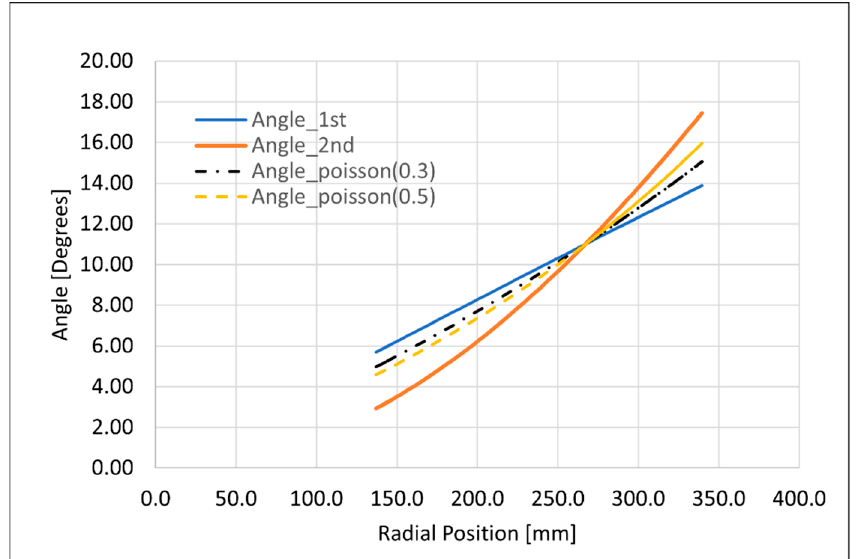
Figure 3. Calculated ply angles from Equation (1) to Equation (3) at R = 267mm, θ = 11 ◦ .